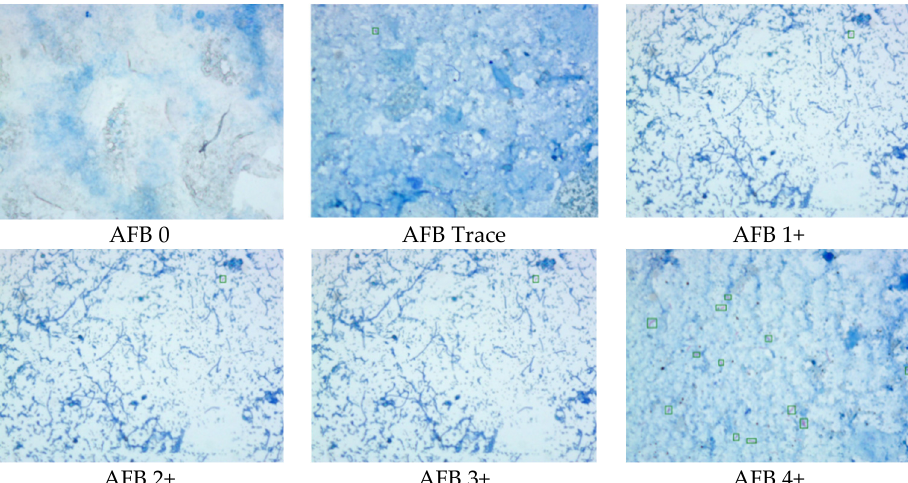
Table 6. The precision and error rate of the automation system and manual microscopy. The “True” represents the cases diagnosed correctly; the “False” represents the cases of wrong diagnosis, after removal of inadequate cases. Figure 2. The automated microscopy system: ( a ) an eight-slide tray in one run. ( b ) The fixed 1 cm × 2 cm area where microscopy scanning. The slides of 1, 2 and 3 were inadequate smears, the slides of 4 and 5 (marked with red square) were adequate smears. The number represents the five different slides. ( c ) The fixed 1 cm × 2 cm area on the slide was divided into 10 small areas to be scanned one by one. The 10 areas were marked with the number from 1 to 10. When the suspicious bacteria are detected, the system will indicate the location of area number.